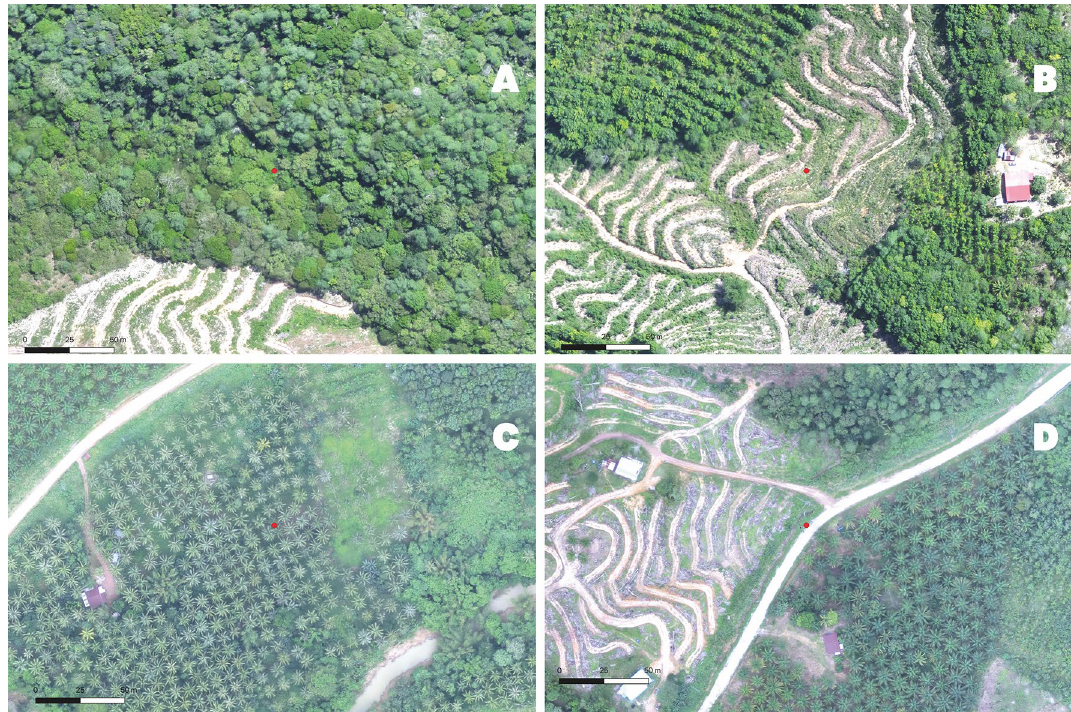
Figure 5. Examples of vegetation density levels. ( A ) Dense vegetation, ( B ) Patchy vegetation, ( C ) Planted vegetation, ( D ) Sparse vegetation. The red point represents the water body being categorised.